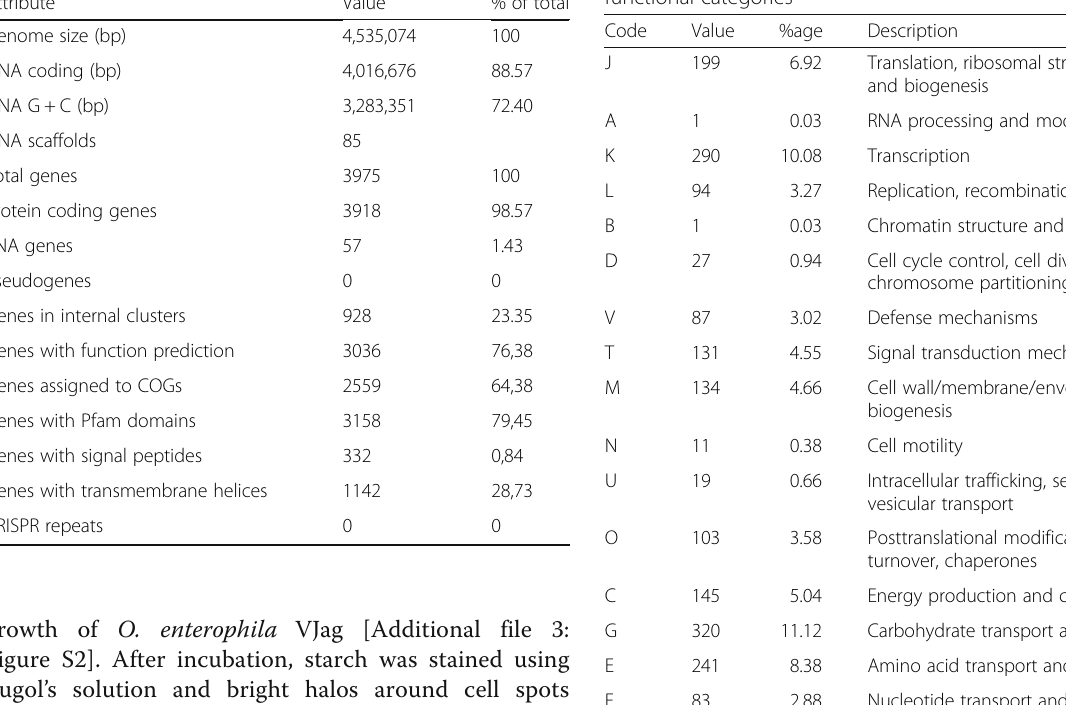
Table 3 Genome statistics Table 4 Number of genes associated with general COG functional